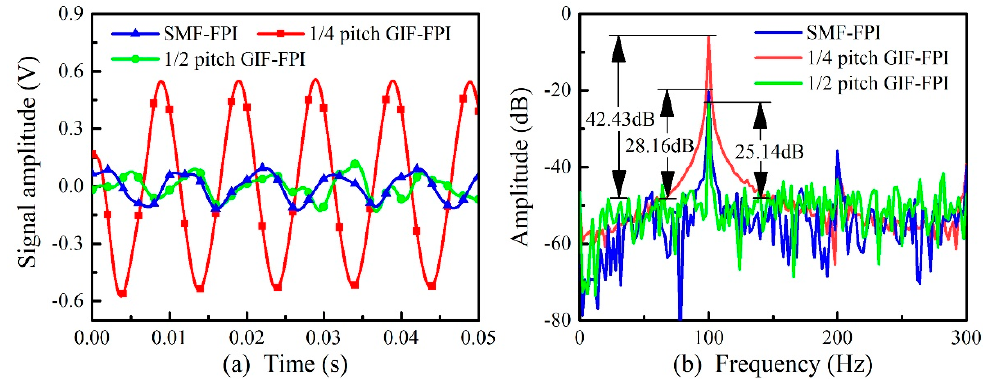
Figure 6. The time domain ( a ) and the frequency domain ( b ) for vibration response of an SMF-FPI, a quarter-pitch GIF-FPI and a quarter-pitch GIF-FPI with a cavity length of 200 μ m at 100 Hz.